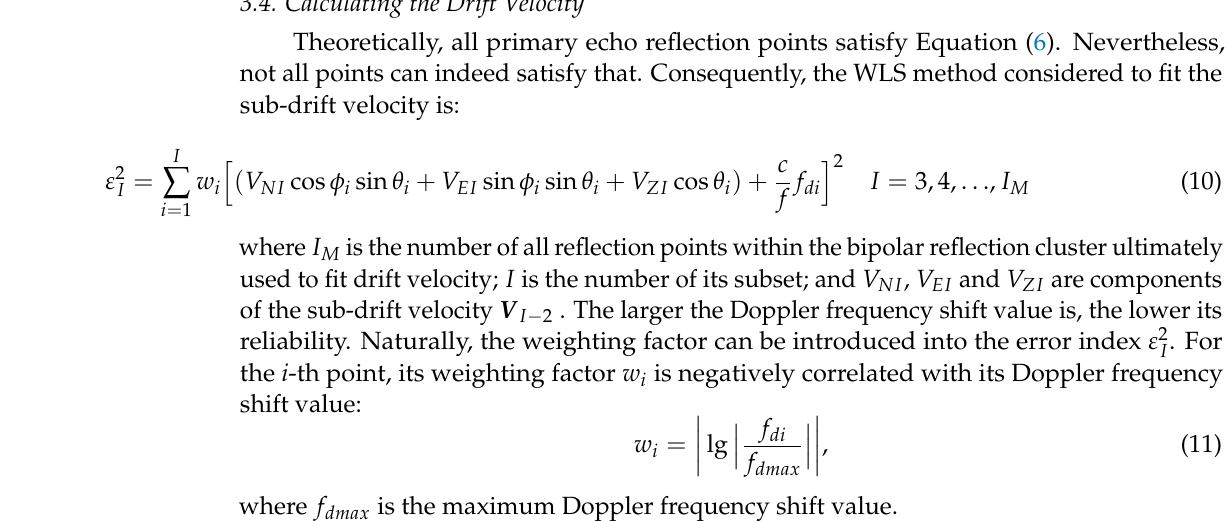
Figure 7. Clustering analysis results of ten clustering